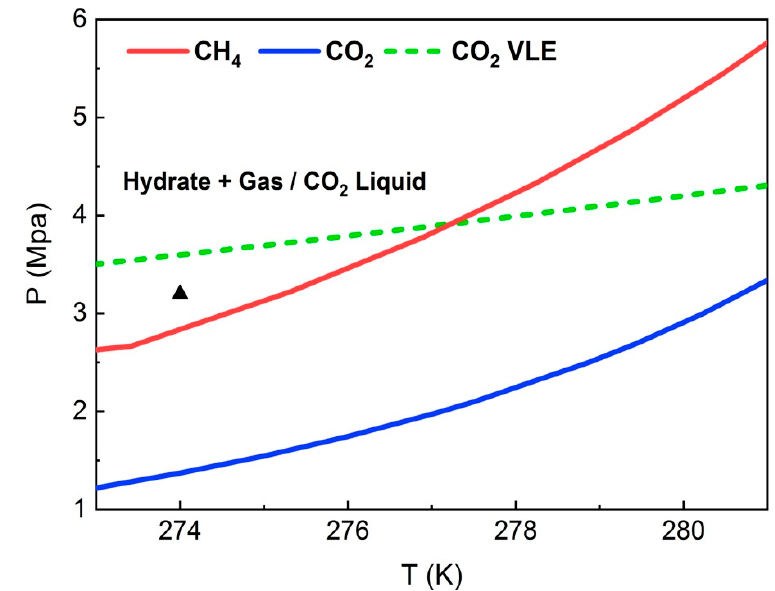
Figure 1. Phase boundaries of the hydrates formed from pure CH 4 (red line), and pure CO 2 (blue line) calculated using CSMGem [2]. Also shown is the CO 2 vapor–liquid boundary (green dashed line) and experimental p-T condition (triangle symbol) at 3.2 MPa and 274 K that is maintained throughout the entire process, including CH 4 formation and the gas replacement process.